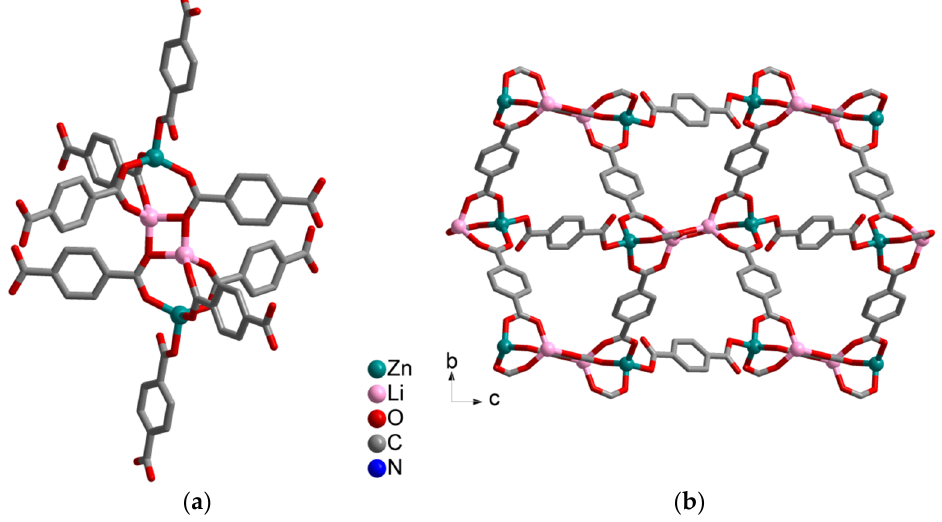
Figure 2. ( a ) SBU in compound 1 ; ( b ) Structure view of 1 along a axis. According to single crystal XRD data compound [Li 2 Zn 2 (H 2 Br 2 -bdc) (Br 2 -bdc) 3 ] · 2DMA ( 2 DMA ) crystallizes in the triclinic space group P –1. Although the unit cell parameters and space group of compound 2 differ from those of compound 1 these compounds are isoreticular. The starting {Li 2 Zn 2 } core also conserves its structure (Figure 3a). Zn–O OCO bond distances values are from 1.933(4) to 1.984(4) Å, Li–O OCO bond distances are from 1.879(13) to 1.956(12) Å which are almost the same as the bond distances in 1 . Nevertheless the values of the square angles O OCO –Li–O OCO and Li–O OCO –Li change to 92.0(5) and 88.0(5) deg., respectively. Each [Li 2 Zn 2 (OOCR) 8 ] node is linked by eight dibromoterephthalates, two of which are protonated. In the H 2 Br 2 -bdc linker the C–O OH distance is 1.218(8) Å, which is slightly shorter than for C–O OZn (1.270(8) Å). Moreover, the Zn–O OCO bond distance for the H 2 Br 2 -bdc linker is the same as the Br 2 -bdc 2 − linker one. In this case a neutral framework is formed (Figure 3b). There are only 0D cavities (approx. 5 × 13 Å) in the structure due to the Br substituents in the terephthalate linker (Figure S2a). The guest accessible volume is 23.4% according to Mercury calculations [42]. The inner volume is filled with guest molecules of DMA. The O atom of a DMA molecule is connected with a protonated carboxylate group of the dibromo- terephthalate linkers by a hydrogen bond (O . . . O distance is 2.843 Å). According to single crystal XRD data compound [H 2 N(CH 3 ) 2 ][LiZn 2 (ndc) 3 ] · CH 3 CN ( 3 ) crystallizes in the monoclinic space group C 2/ c . In this structure the starting {Li 2 Zn 2 } core fragments into dinuclear {LiZn} blocks. In these blocks cations are connected by two bridging naphthalenedicarboxylic linker carboxylates. {LiZn} blocks engage individual Zn 2+ cations from the reaction mixture and form trinuclear secondary building units {LiZn 2 }. These SBUs bind with each other using pairs of bringing carboxylates to form chains along the c axis (Figure 4a). Thus all cations in the structure are in a